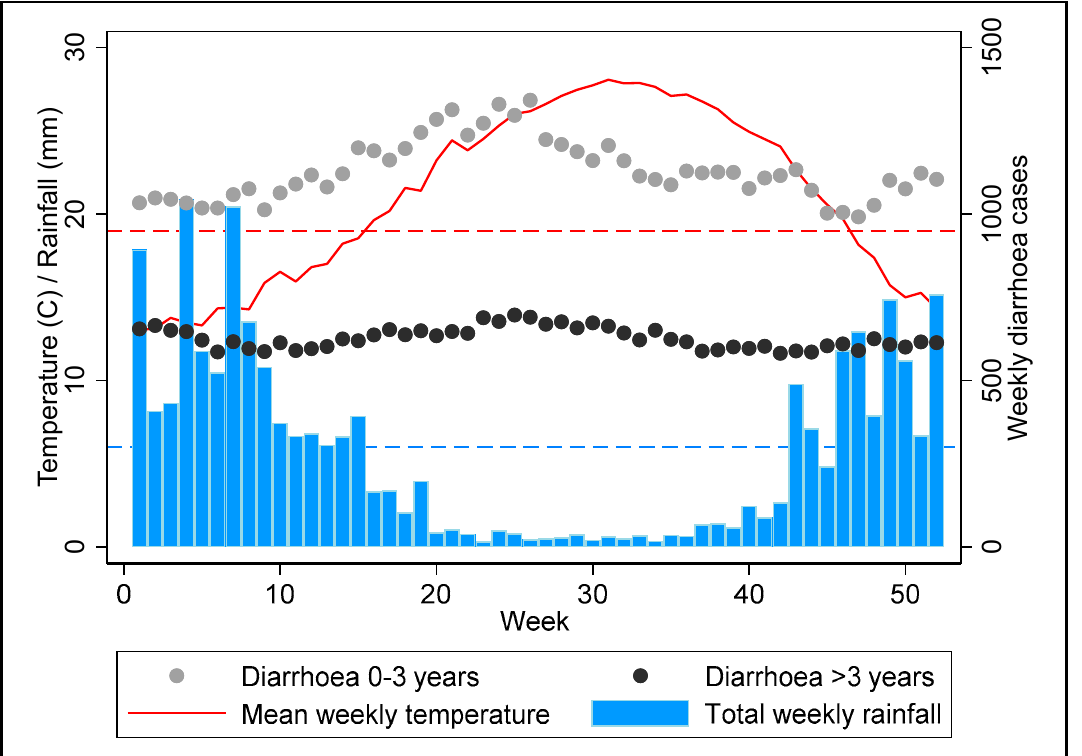
Figure 2. Annual distribution of weekly diarrhoea cases and climate factors across years 2009–2020. The dashed red and blue lines denote threshold values for temperature (>19 °C) and rainfall (<6 mm) respectively.